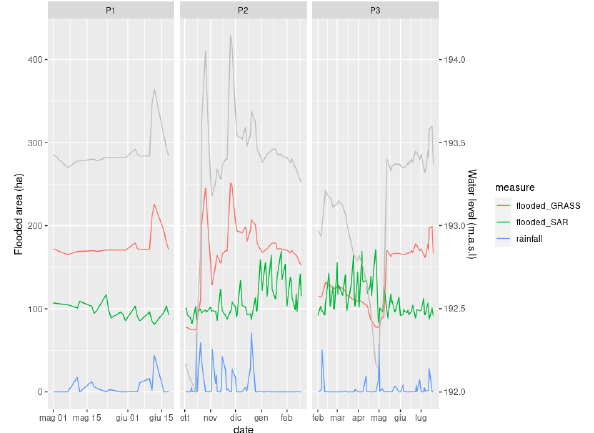
Figure 2. Temporal trend of total flooded area calculated with SAR and GRASS GIS in the protected area of Bolle di Magadino near lake Maggiore (CH) during the three periods of monitoring. The left x axis reports the hectares of inundated area and mm of rainfall, the grey line shows the lake water level reported on the right y axis